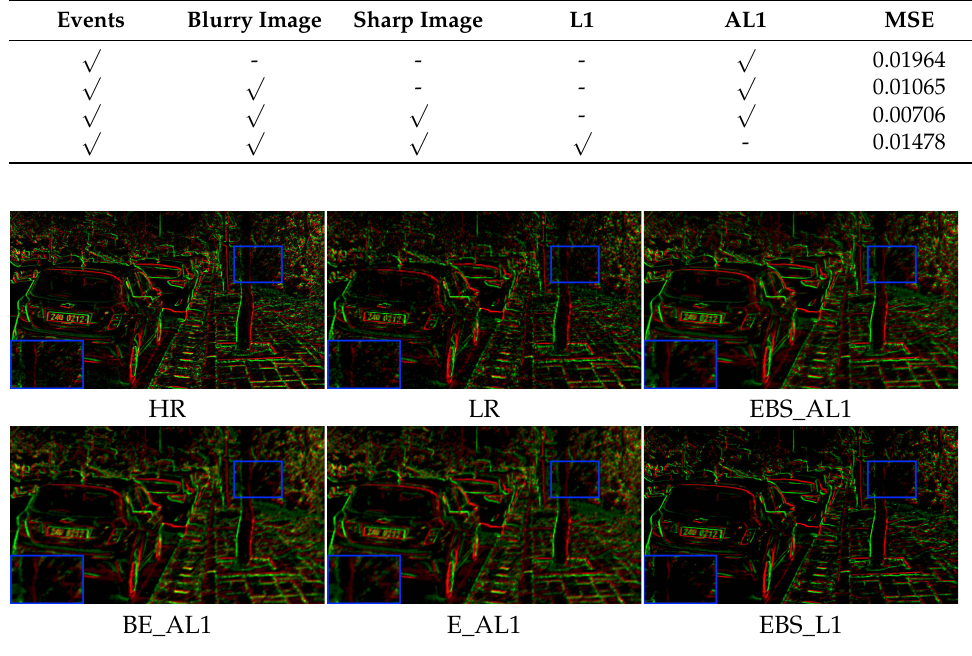
Figure 6. Visualization of EventSRNet learning with different settings. HR and LR are events captured under × 1 and × 4 spatial resolution. ‘E’, ‘B’, and ‘S’ here mean that the inputs of EventSRNet contain events, blurry images, and sharp image, respectively. ‘AL1’ and ‘L1’ mean learning EventSRNet with asymmetric L1 loss and normal L1 loss. The proposed method with all EBS and AL1 tends to obtain a clearer and more structured result. Without sharp images, BE_AL1 and E_AL1 appear blurry. Furthermore, the result attained with L1 loss tends to lose